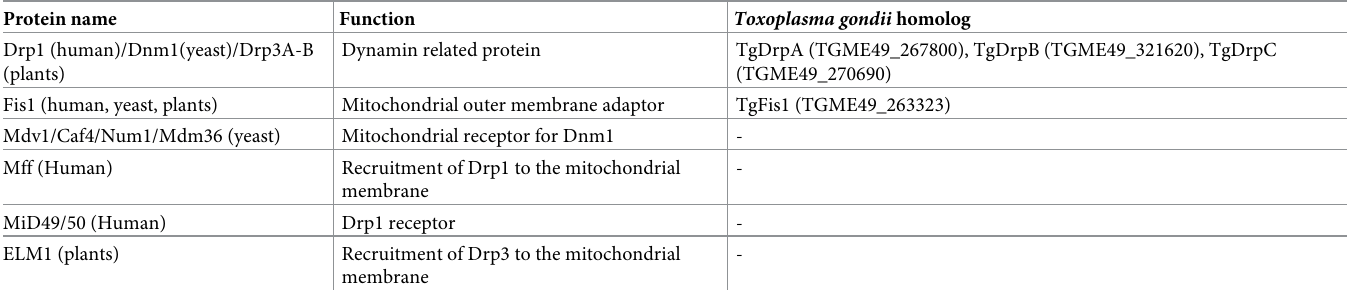
Table 1. known factors involved in mitochondrial fission in yeast, humans and plants and their conservation in T . gondii